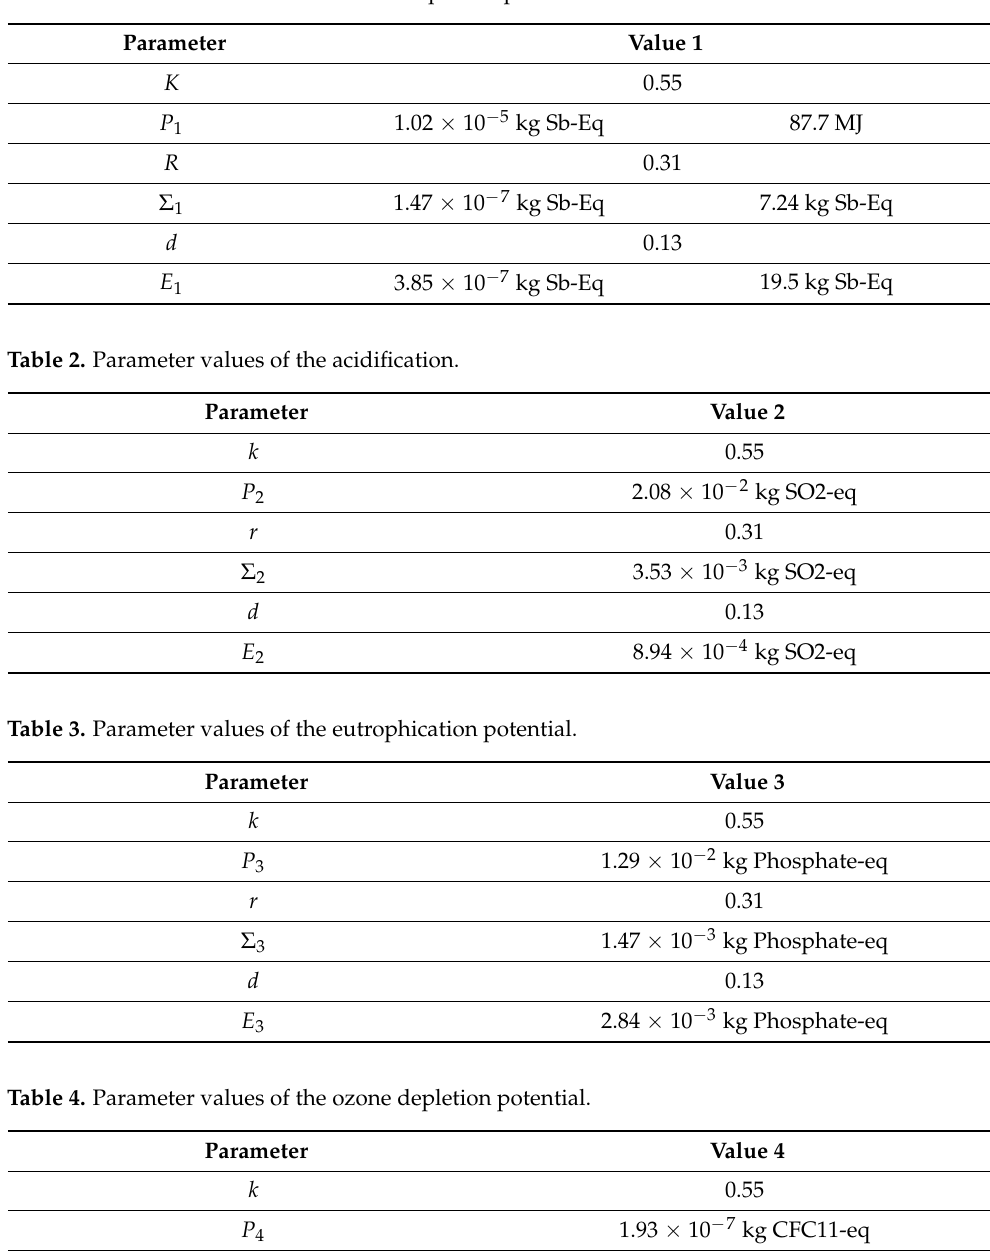
Table 1. Parameter values of the abiotic depletion potential.